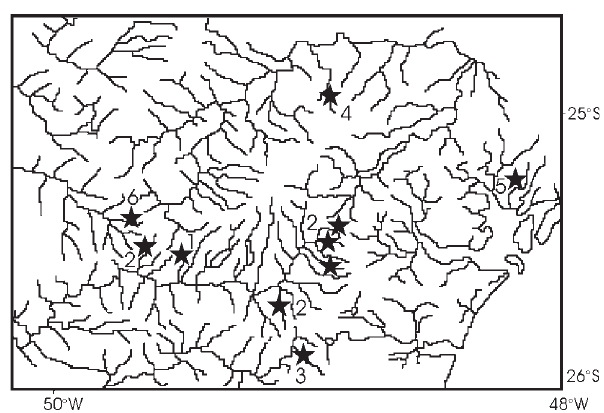
Fig. 1. Geographic distribution of the material examined (stars): (1) Astyanax totae sp. n., rio Tortuoso basin, upper rio Iguaçu basin; (2) Astyanax sp. D, upper rio Iguaçu drainages; (3) Astyanax sp. F, rio da Várzea, rio Iguaçu basin; (4) Astyanax janeiroensis , rio Ribeira basin; (5) Astyanax aff. scabripinnis , rio Morato, coastal drainage of southeastern Brazil; (6) Astyanax sp., rio Tibagi, upper rio Paraná